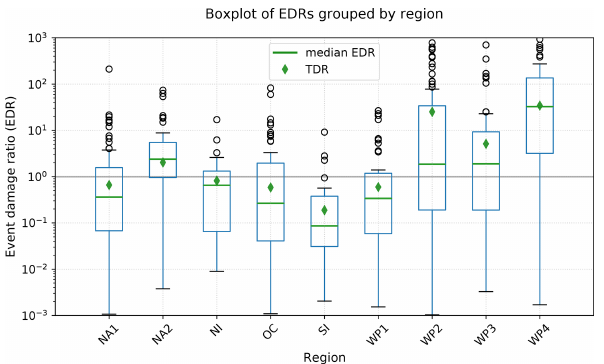
Figure 4. Spread of event damage ratio (EDR; boxplot) and total damage ratio (TDR) per region before calibration ( V half = 74.7ms − 1 ) per region. The plots are based on data from 473 TC events affecting 53 countries. The EDR boxplots show the median (green line), the first and third quartiles (IQRs; blue box), data points outside the IQR but not more than 1.5 · IQR dis- tance from either the first or the third quartile (black whiskers), and outliers (black circles). The additional markers show TDRs before calibration (green diamond). The regions are the Caribbean with Central America and Mexico (NA1), the USA and Canada (NA2), North Indian Ocean (NI), Oceania with Australia (OC), South In- dian Ocean (SI), South East Asia (WP1), the Philippines (WP2), mainland China (WP3), and the rest of the north West Pacific Ocean